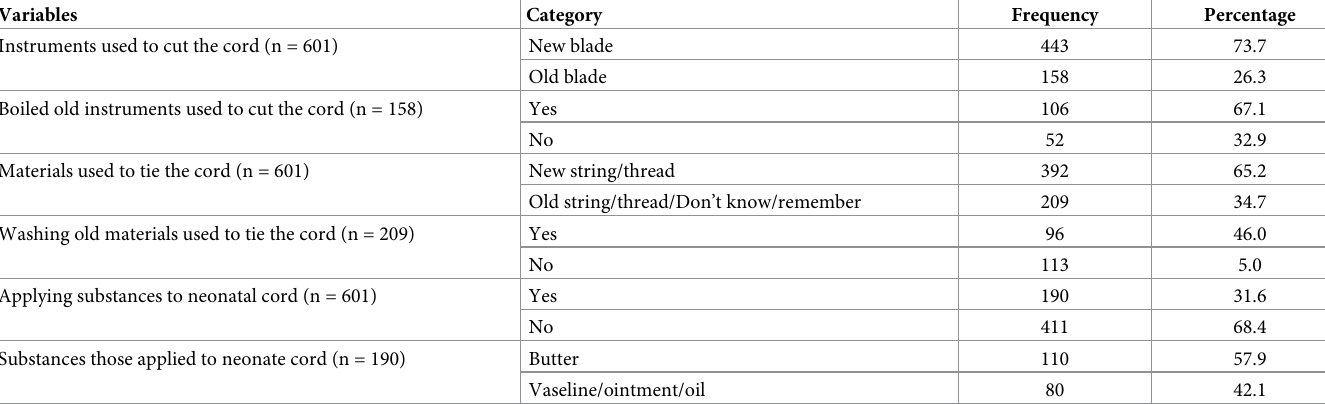
Table 5. Cord care practice among home delivered women, in Guto Gida district, Oromia regional state, Ethiopia, September 2020.